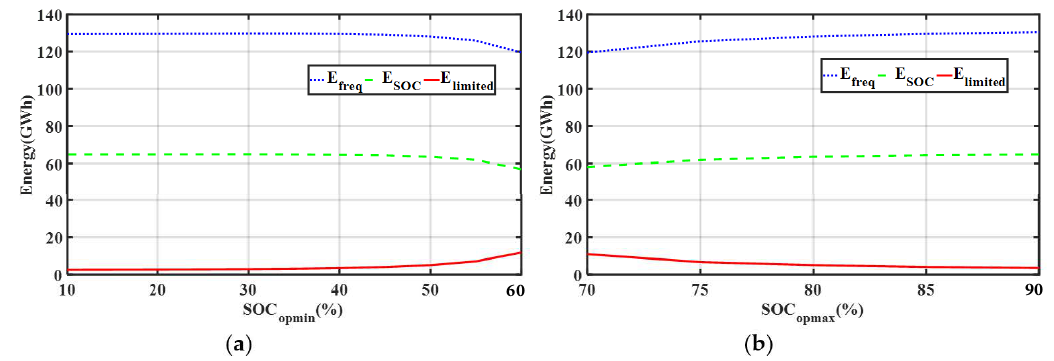
Figure 11. Objective function changes according to droop index changes.